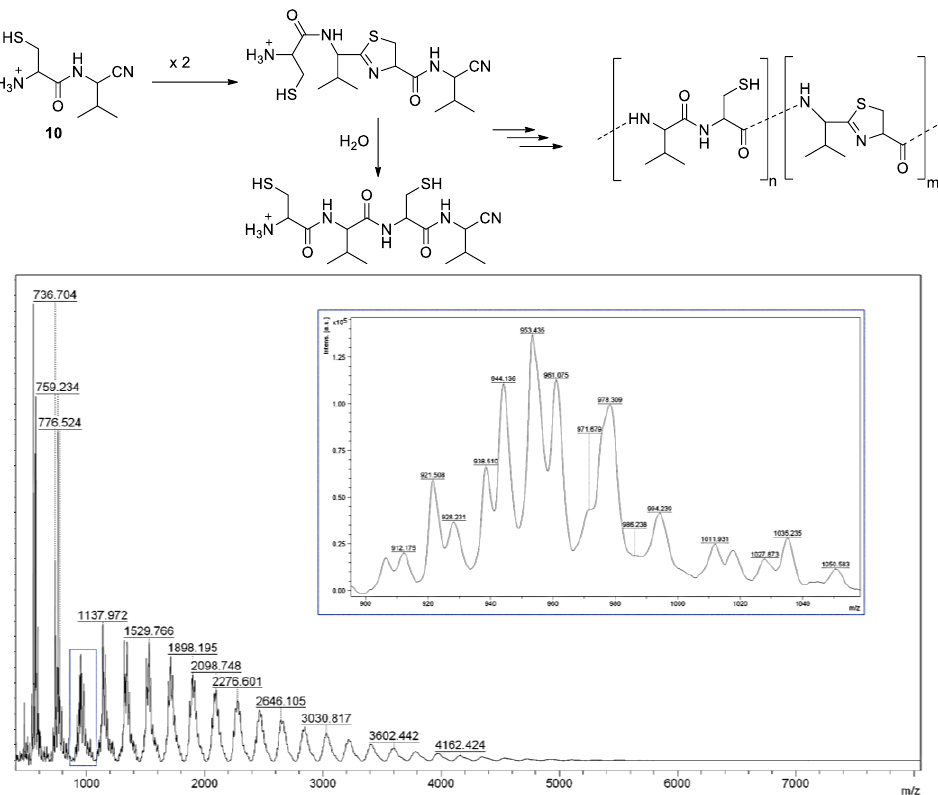
Figure 1. Peptides obtained from aminothiol-containing amidonitriles: polymerization scheme for Cys-Val-CN 10 and MALDI mass spectrum of the obtained mixture with enlargement of the zone corresponding to (Cys-Val) 5 . (Cys: cysteine, Val: valine).